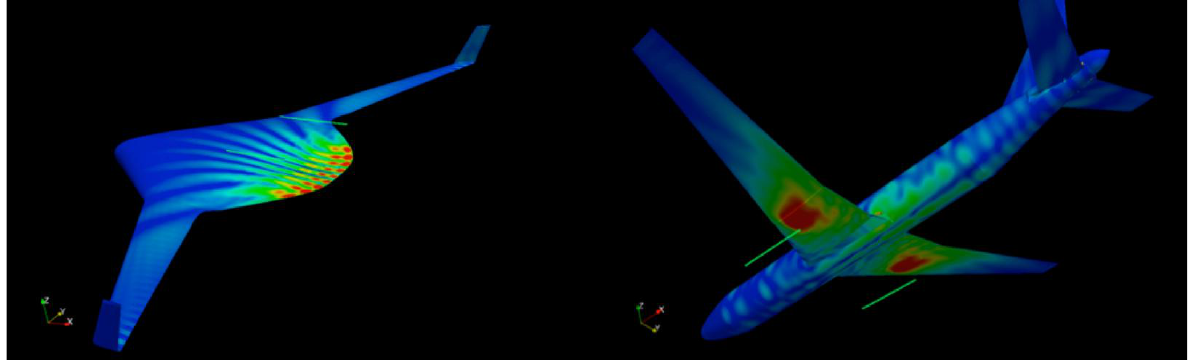
Figure 13: Total SPL distribution induced by jet noise at 200 Hz on the surface of the BWB and a classic configuration of the same